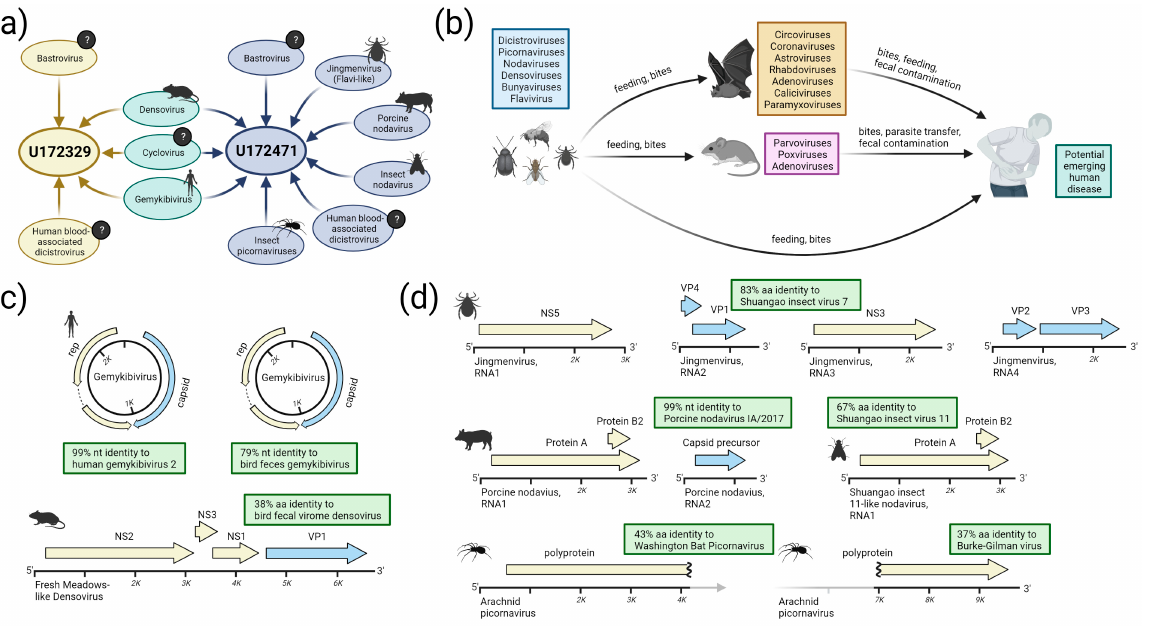
Figure 2. Summary of non-HxV viruses recovered from specimens U172329 and U172471. ( a ) Viral families from which a partial or complete genome was recovered from each specimen. Identical sequences of the novel densovirus, novel cyclovirus, and known human gemykibivirus 2 were found in both specimens. ( b ) Schematic depicting predation/encounter scenarios that may transmit viral genetic material from lower animals to higher animals. ( c ) Assembled genomes for known and novel DNA viruses described in panel A. ( d ) Assembled genomes for known and novel RNA viruses described in panel A. (Figure created with BioRender.com).